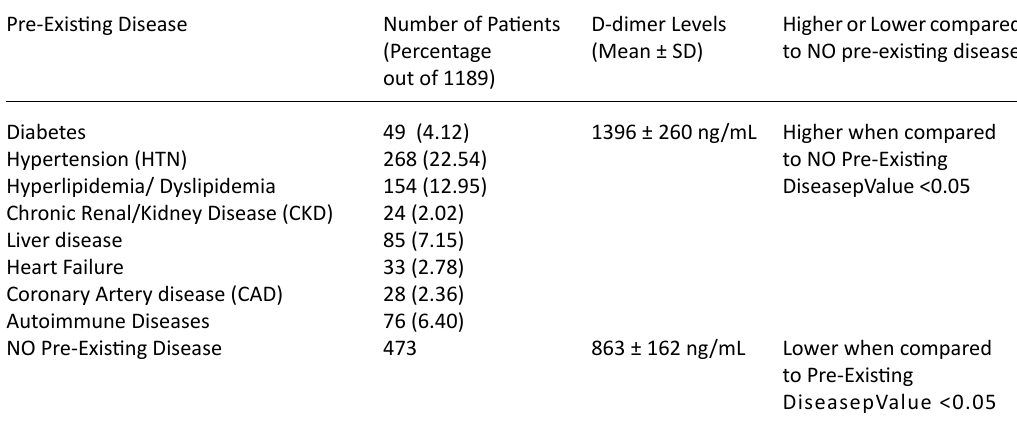
Table 3. D-dimer levels comparison with pre-existing disease Pre-Existing Disease